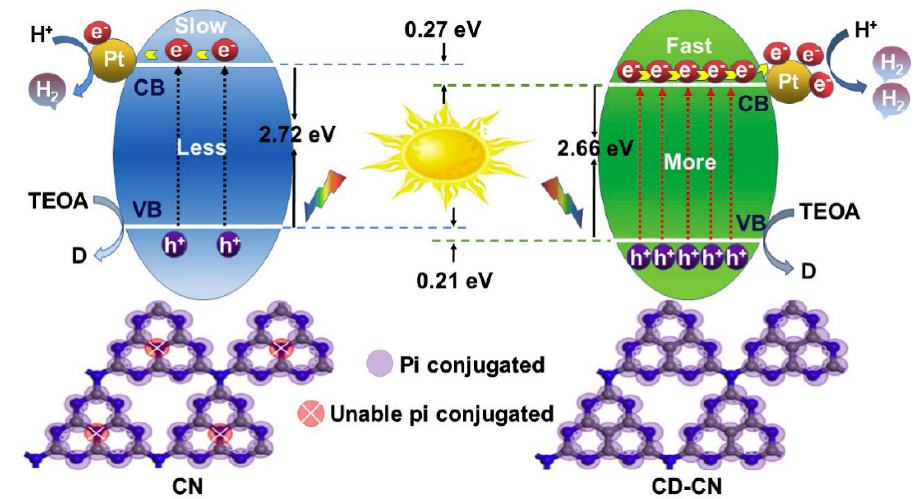
Figure 11. Proposed mechanism for Pt-deposited g-C 3 N 4 (CN) and C-g-C 3 N 4 (CD-CN) of visible-light photocatalytic performance; TEOA is triethanolamine and D is oxidation products. Reprinted from [71] Copyright (2020), with permission from Elsevier.